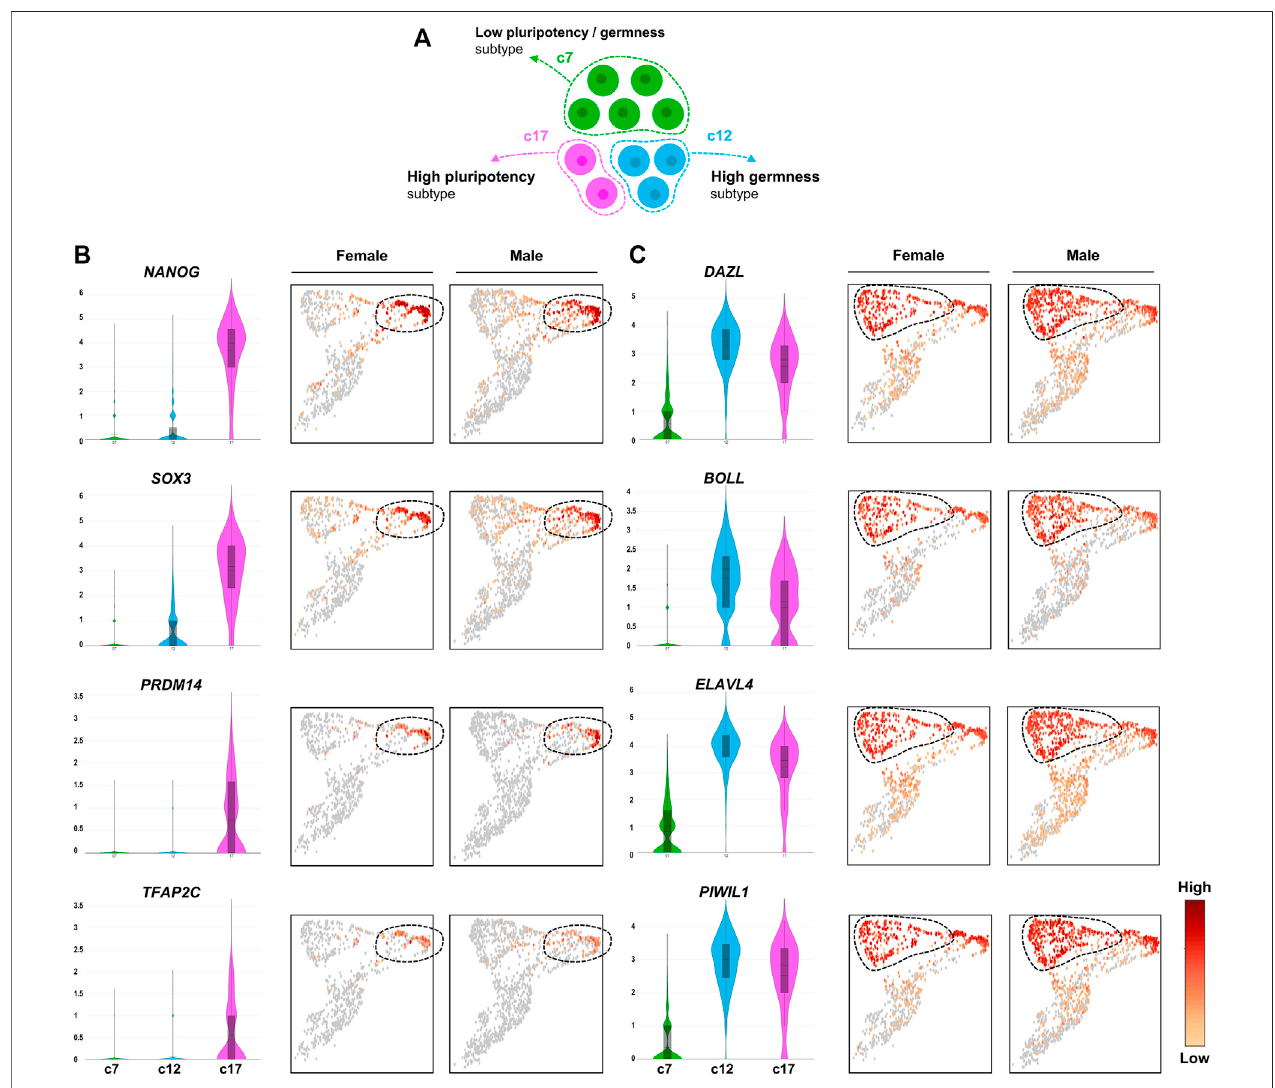
FIGURE 3 | Heterogeneous expression of PGC marker genes. (A) Illustration of heterogeneous features among PGC subpopulations. (B) UMAPs showing high expressionofearlyPGCmarkergenes(pluripotencymarkers)incluster17. (C) UMAPsshowinghighexpressionoflatePGCmarkergenes(germnessmarkers)incluster 12. The number of the Y -axis mean log